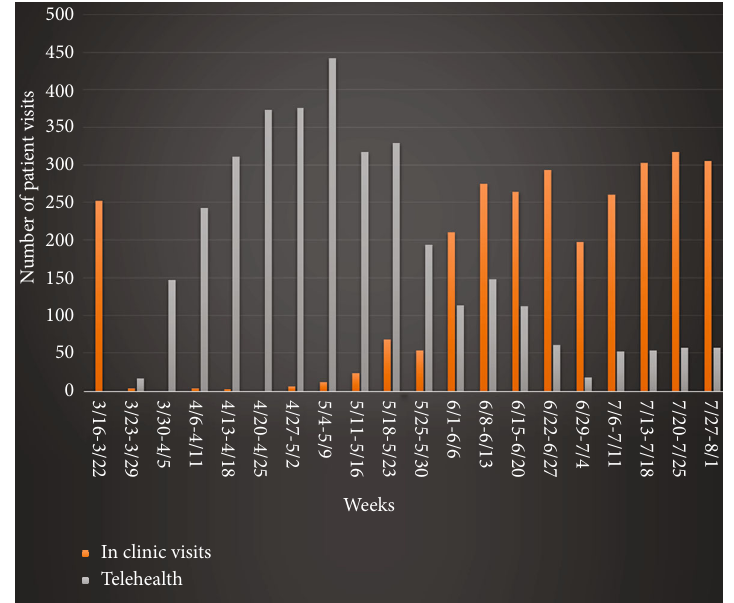
Figure 4: Total number of visits conducted at the neurology clinic from 3/16/20 to